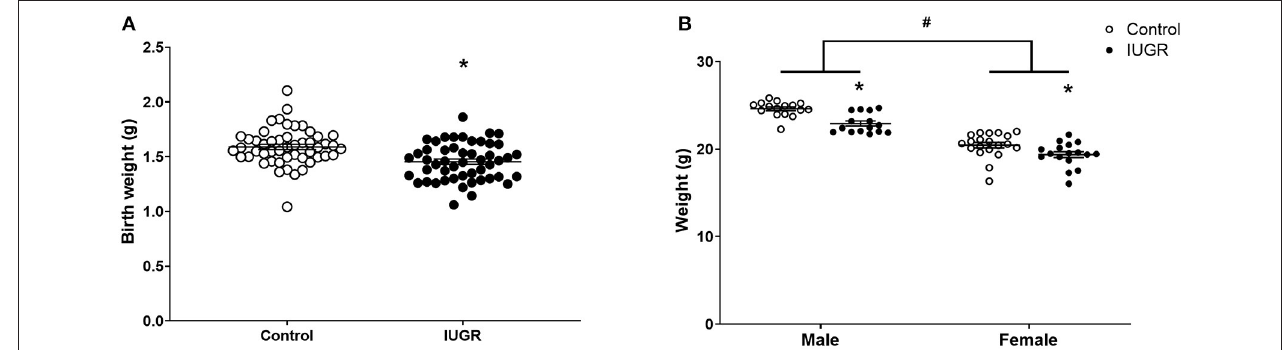
FIGURE 2 | Offspring body weights. Body weights of Control ( n 50) and IUGR ( n 50) offspring at birth (A) and at 8 weeks of age (Control male, n = = male, n 15; Control female, n 20; IUGR female, n 17; B ). Sample size of birth weight is larger than experimental sample size as the birth weight of all pups in = = = each litter was recorded. Data are mean SEM. *Significant treatment effect ( P < 0.05). # Significant sex effect ( P < 0.05). IUGR, intrauterine growth ±